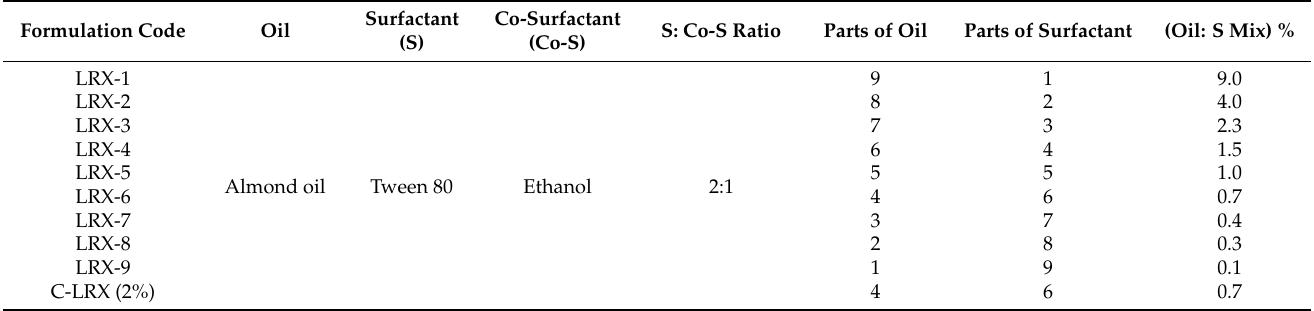
Table 2. Formulations of LRX prepared with varying ratios of oil and surfactant molecules.